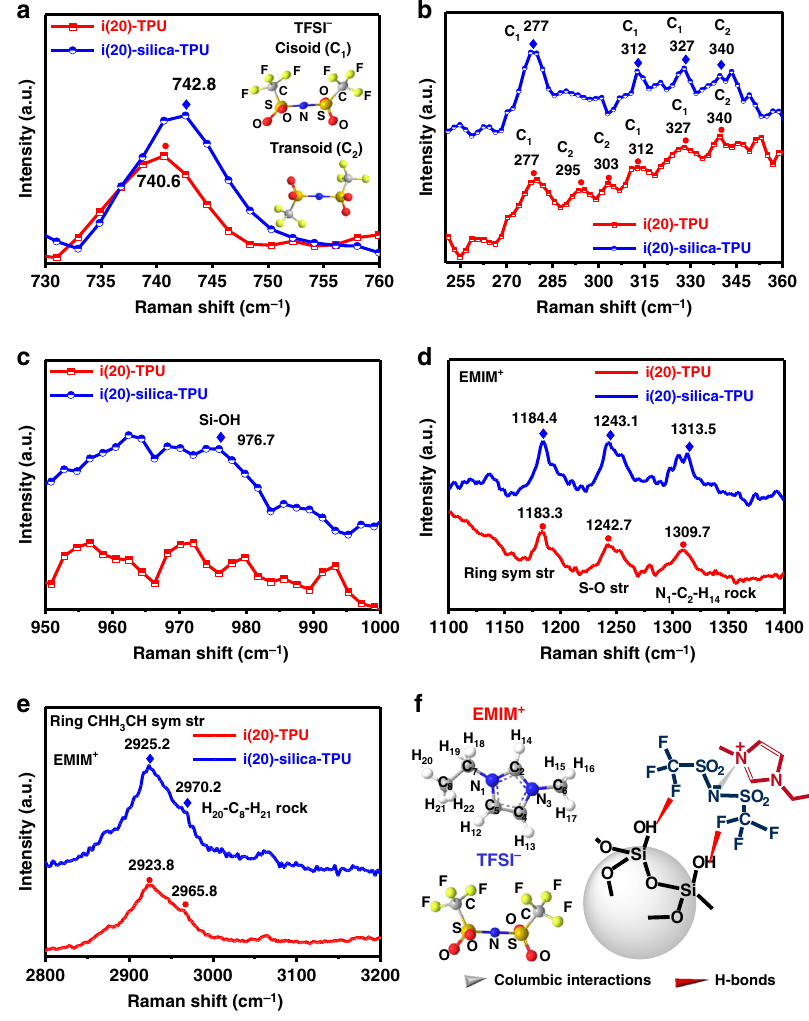
Fig. 3 Molecular characterization of IL(20 wt%) – silica – TPU SMHIP. a The Raman spectra in the spectral range 730 – 760 cm − 1 (corresponding to TFSI − anion expansion – contraction mode). Inset shows the two conformations of TFSI − anion, the cisoid (or C 1 ) and the transoid (or C 2 ). b Raman spectra of TFSI − conformational sensitive range 250 – 360 cm − 1 . c Si – OH Raman stretching observed at 976.7cm − 1 in i(20) – silica – TPU. d , e Raman spectra in the spectral ranges 1100 – 1400cm − 1 and 2800 – 3200cm − 1 (corresponding to EMIM + vibrational bands). f Schematic of molecular structures of [EMIM + ] (with its atomic number scheme used in d , e ), [TFSI − ] (with its atomic labeling), and the nature of interactions between silica and [EMIM + ][TFSI − ] ion pairs in i (20) – silica – TPU SMHIP. Source data for a – e are provided as a Source data fi